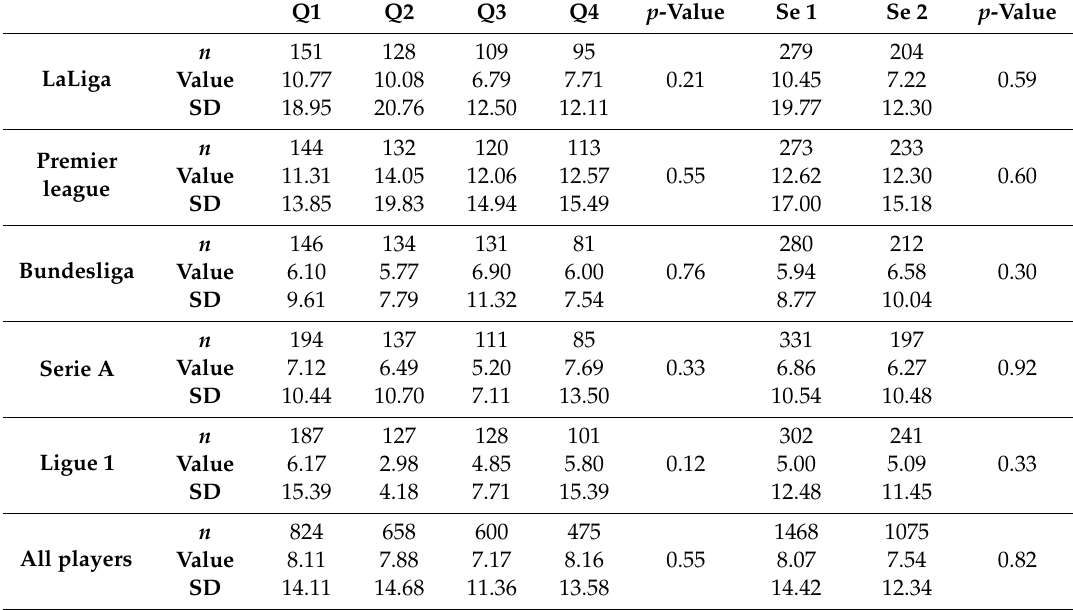
Table 4. Estimated average value ( € million) of European League soccer players (2017 / 2018) according to their quarter (Q) or semester (Se) of birth.